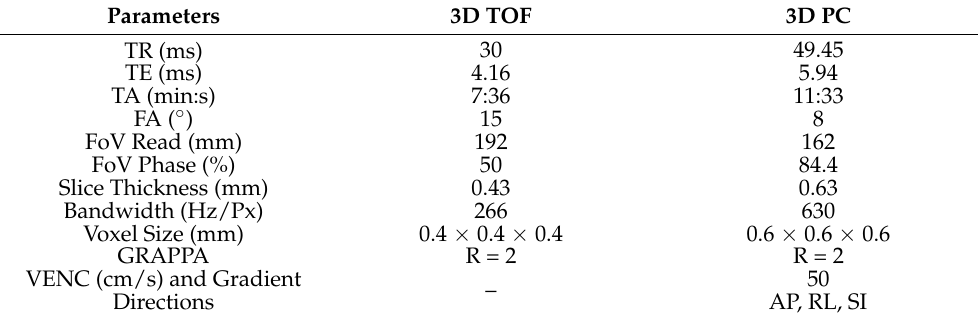
Table 1. Magnetic resonance (MR) imaging